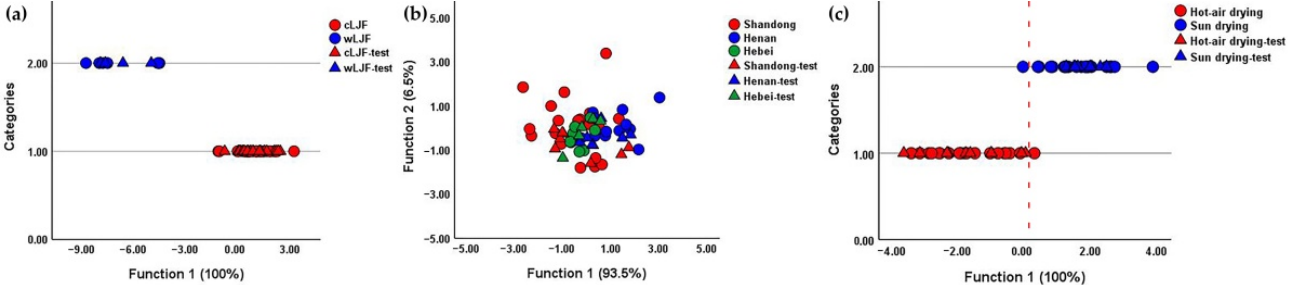
Figure 3. LDA scores plots of LJF samples based on 6 bioactive peaks. ( a ) LDA scores plot for LJF samples according to cultivation pattern. ( b ) LDA scores plot for cLJF samples according to geographical origin. ( c ) LDA scores plot for cLJF samples according to processing method.